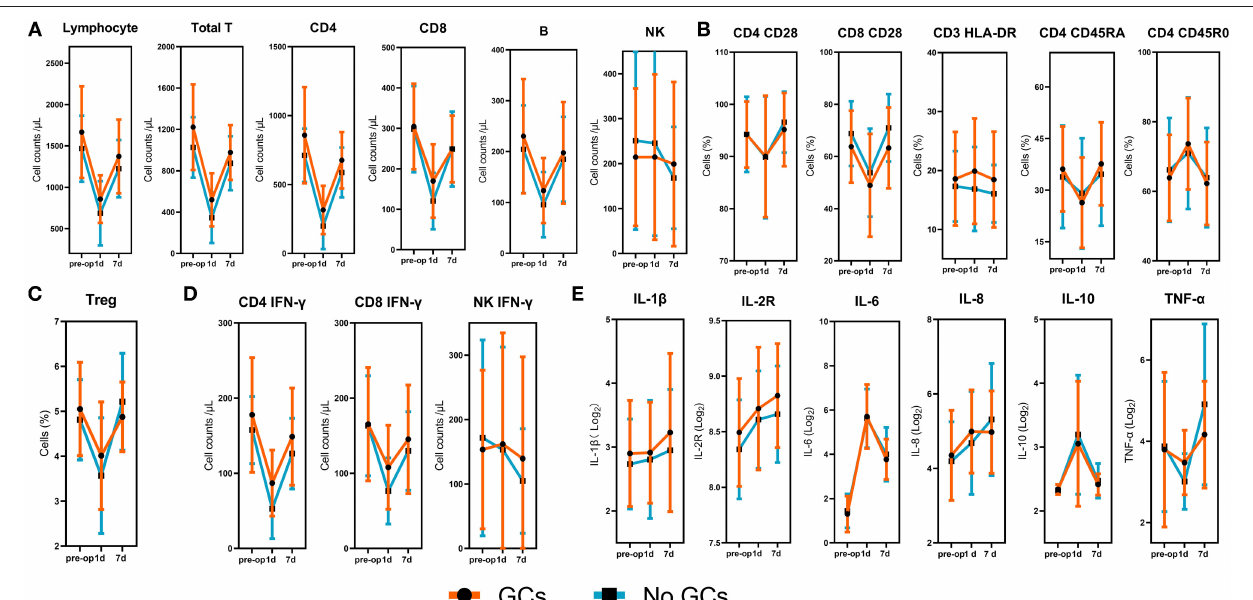
FIGURE 1 | Dynamic changes of lymphocyte subsets, lymphocyte phenotypes, lymphocyte functions, and inflammatory factors. (A) The absolute numbers of total lymphocytes, T cells, B cells, NK cells, CD4 + and CD8 + T cells. (B) The expression of CD28 on CD4 + and CD8 + T cells, the expression of HLA-DR on CD3 + T cells, the expression of CD45RO and CD45RA on CD4 + T cells. (C) The percentages of Treg cells. (D) The absolute numbers of IFN- γ producing CD4 + T cells, CD8 + T cells, and NK cells. (E) Logarithms of cytokines based on 2. The p -values for the time trend were > 0.05 for all immune cells and inflammatory